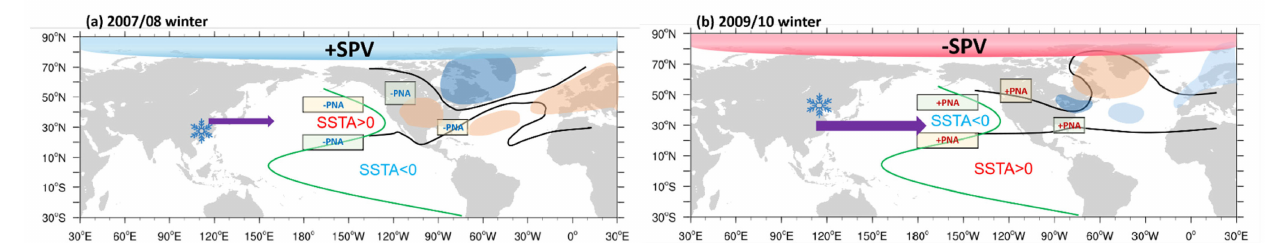
Figure 15. Schematic diagrams depicting the key features of ( a ) the winter of 2007/08 and ( b ) the winter of 2009/2010. The thick black contours are for the total flow, with the northern (southern) contour corresponding to ≈ 305 K ( ≈ 315 K), and the blue (orange) shading area is the warm and cold air in the north Atlantic corresponding to anomalies, the same as in the work of Benedict et al. [6]. The purple arrow denotes the 200-hPa zonal wind in the north Pacific. The thick, green line is the contour where the SST anomaly (SSTA) is equal to 0 ◦ C. The blue (red) shading area in the polar region denotes negative (positive) geopotential height anomalies at level 10 hPa, corresponding to a positive (negative) SPV index. The four black frames are those used to define the PNA index. The snowflake symbol represents the cold and snowy